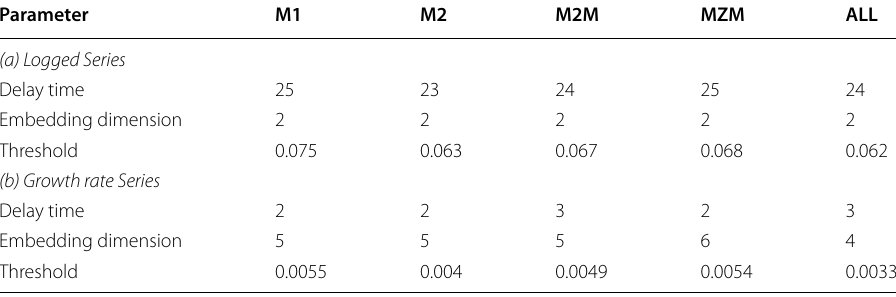
Table 2 Parameter values for the constructions of RPs of broad aggregates Parameter Divisia M3 Divisia M4- Divisia M4 (a) Logged Series Delay time 24 Embedding dimension Threshold 0.06 Delay time Embedding dimension Threshold